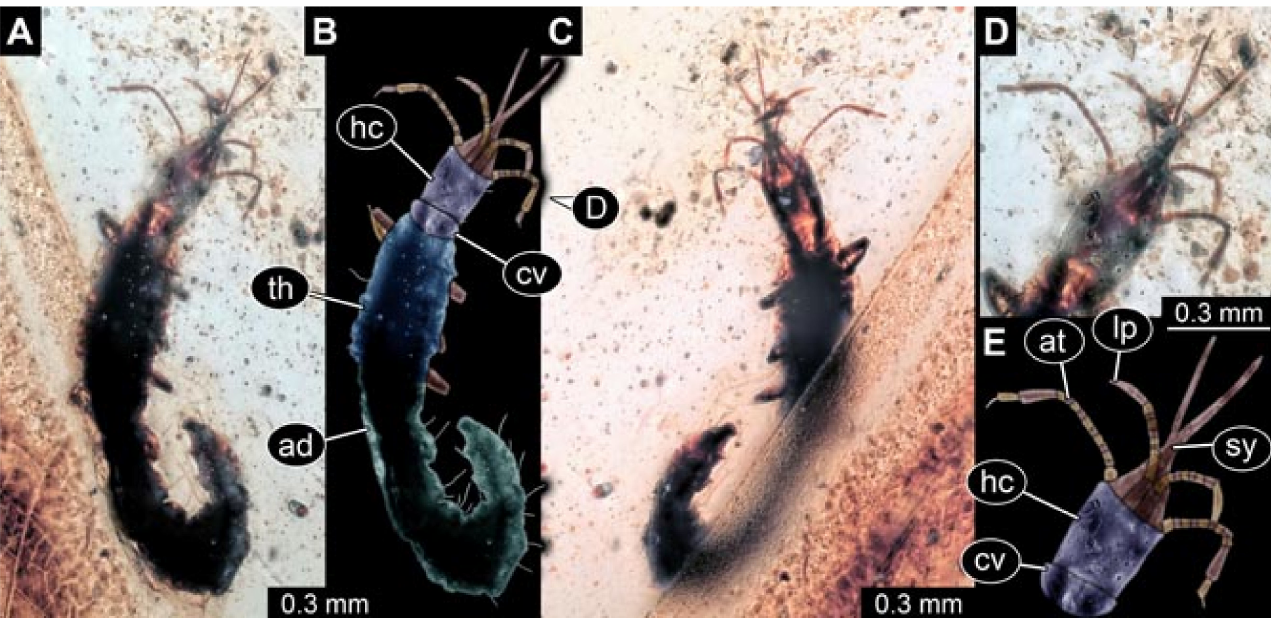
Figure 28. Specimen 5859 (BUB 3737); Myanmar amber. ( A ) Dorsal view. ( B ) Dorsal view, colour-marked. ( C ) Ventral view. ( D ) Close-up of head capsule in dorsal view. ( E ) Close-up of head capsule in dorsal view, colour-marked. Abbreviations: ad = abdomen; at = antenna; cv = cervix; hc = head capsule; lp = labial palp; sy = stylet; th = thorax. (29) Specimen 5862 (PED 0790). The larva is preserved in Myanmar amber. It is